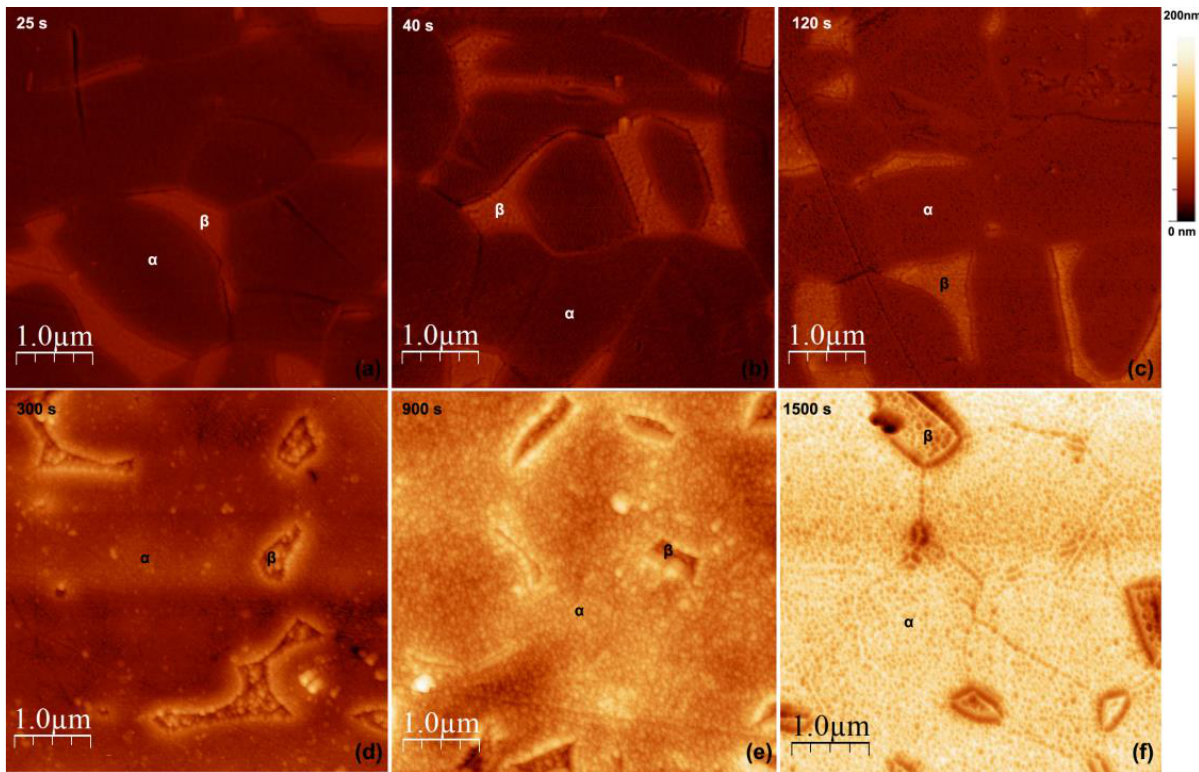
Figure 8. AFM topography maps for specimens anodized at 60 V at ( a ) 25 s, ( b ) 40 s, ( c )120 s, ( d ) 300 s, ( e ) 900 s, and ( f ) 1500 s.